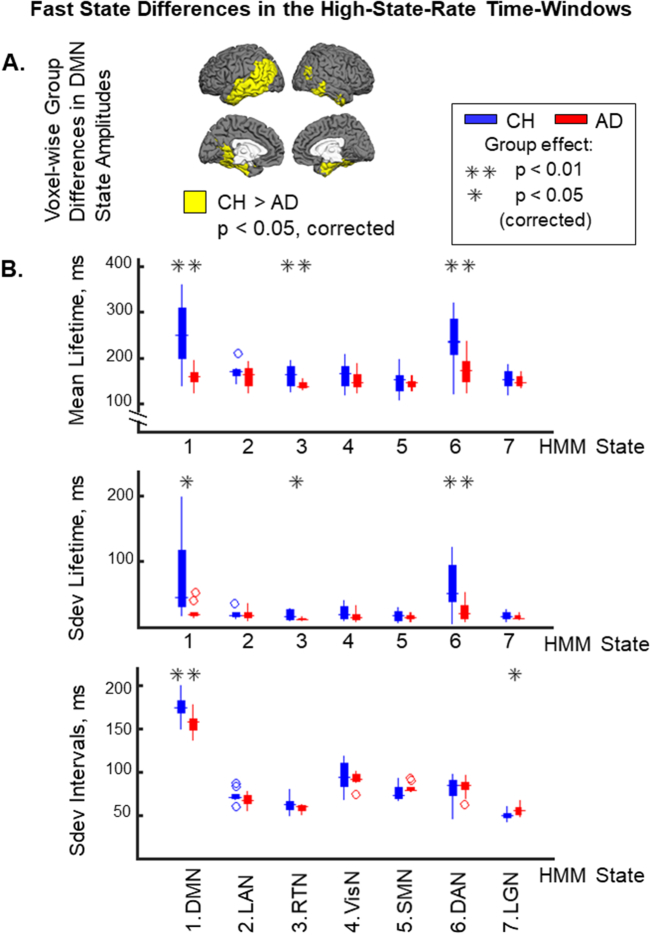
Results selectively within the time-intervals exhibiting increased recurrence rates of individual HMM states. A. Maps of group differences in the voxel-wise activity increase specific to the transient DMN state visits during the time-intervals when the DMN-state rate of occurrence was high. Brain voxels where the state-specific enhancement in the oscillatory amplitude was reduced in the AD relative to CH group are shown in yellow color. B. Group differences in temporal characteristics of the inferred fast states. Boxplots illustrate value distributions (as described in Fig. 6) of mean lifetime (top), standard deviation of lifetimes (middle), and standard deviation of inter-state intervals (bottom) for seven salient states (labeled in the bottom). Abbreviations are the same as in Fig. 2.